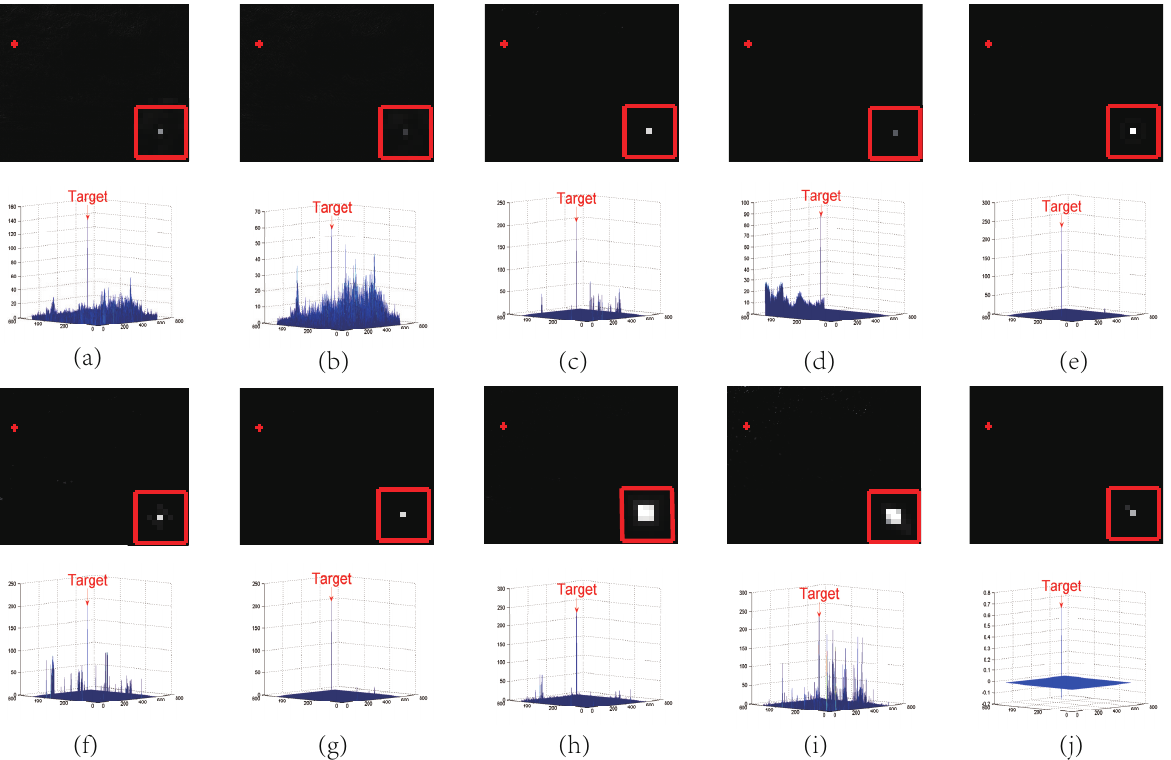
Figure 10. ( a – j ): Top hat, ANI, PSTNN, ASTTV, GST, NTFRA, NRAM, HB-MLCM, ADMD, and the proposed method’s difference diagram and three-dimensional diagram in scene F,